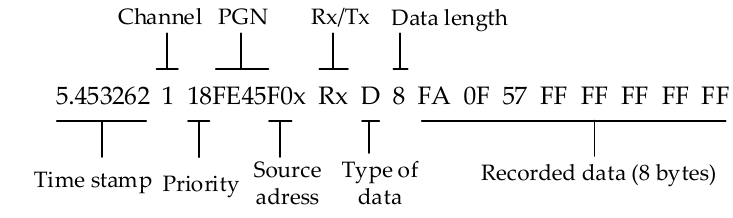
Figure 3. and are indicated as green dots. They can be assigned to the field “Schlag 5” of the examined farm, with a size of 2.90 ha as this was indicated in the field catalogue. Agriculture 2019 , 9 FOR PEER REVIEW